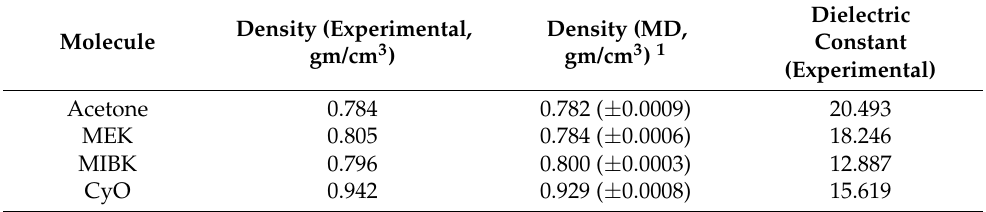
Table 2. Experimental and MD computed physical characteristics of the liquid